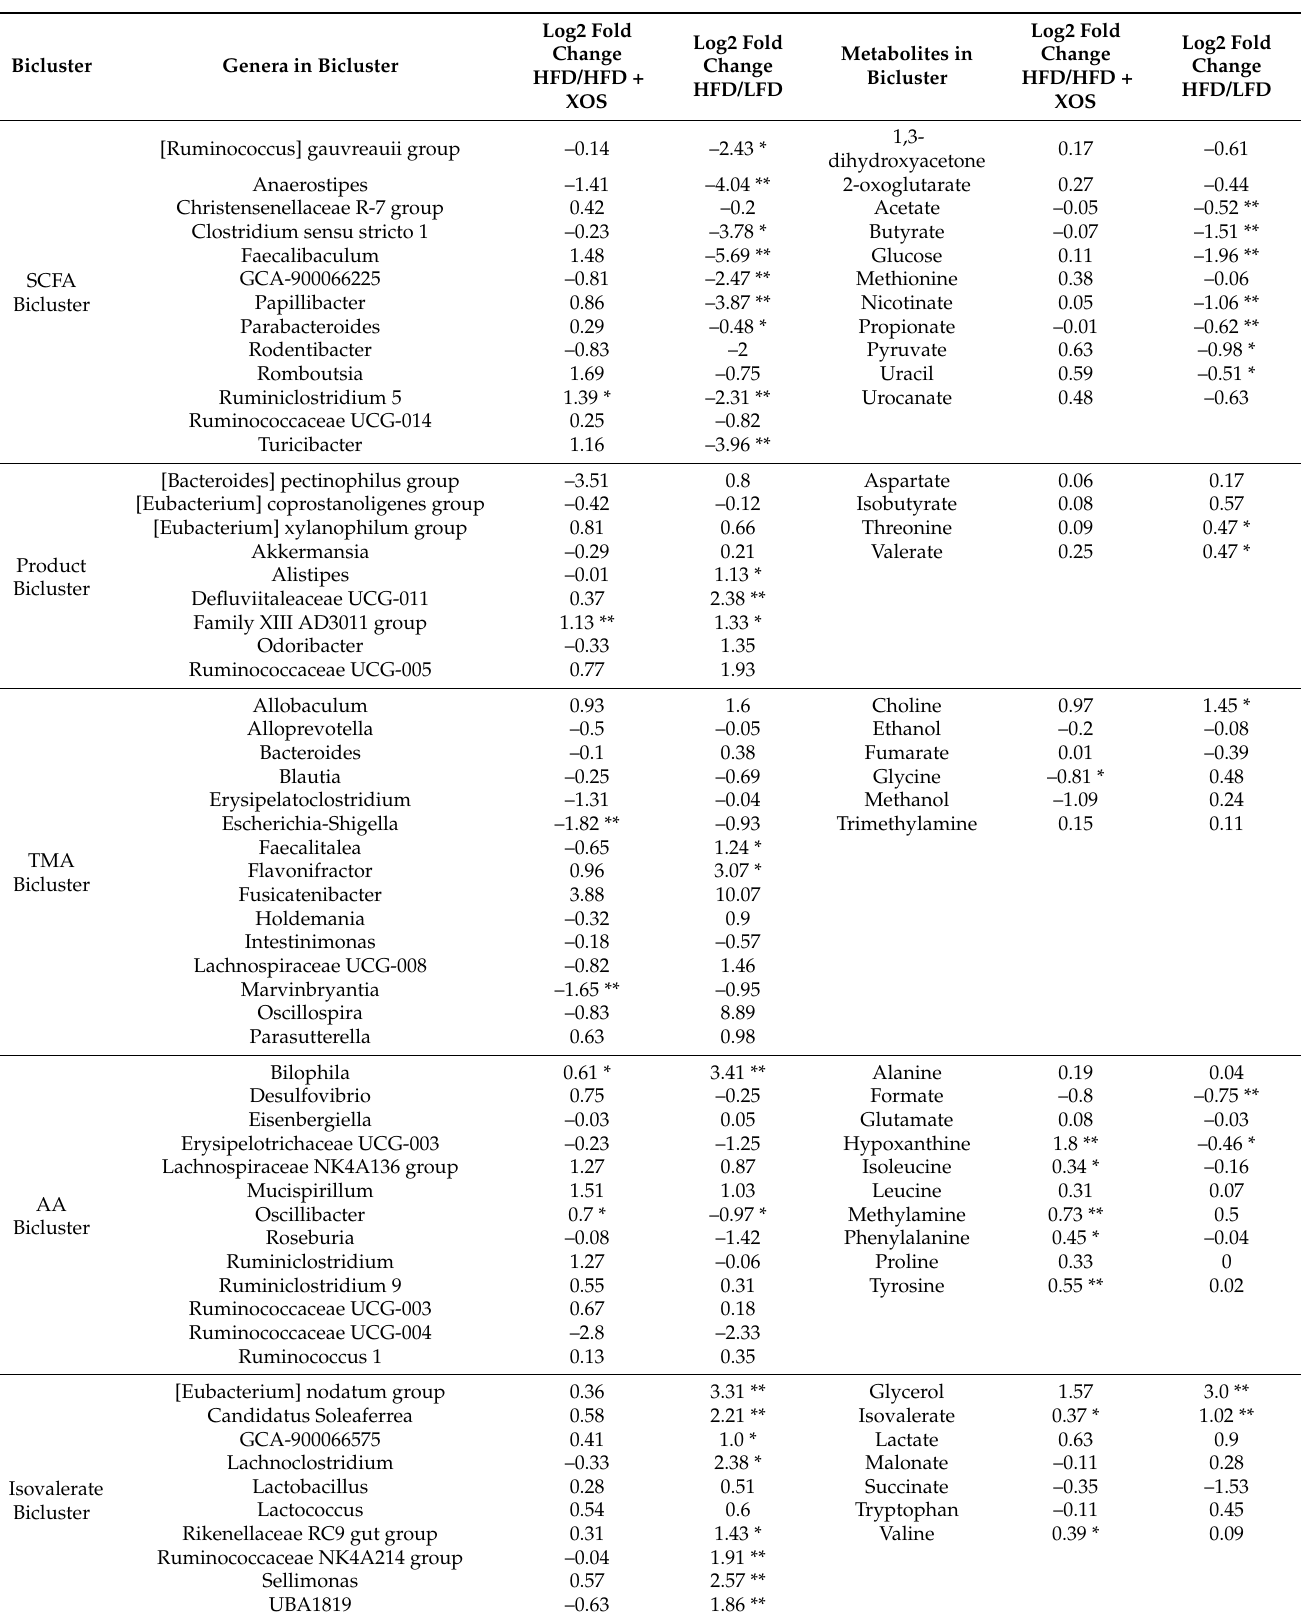
Table 1. The features contained in each bicluster, with non-annotated bacterial genera excluded. Positive log 2 fold change indicates higher abundance in the HFD